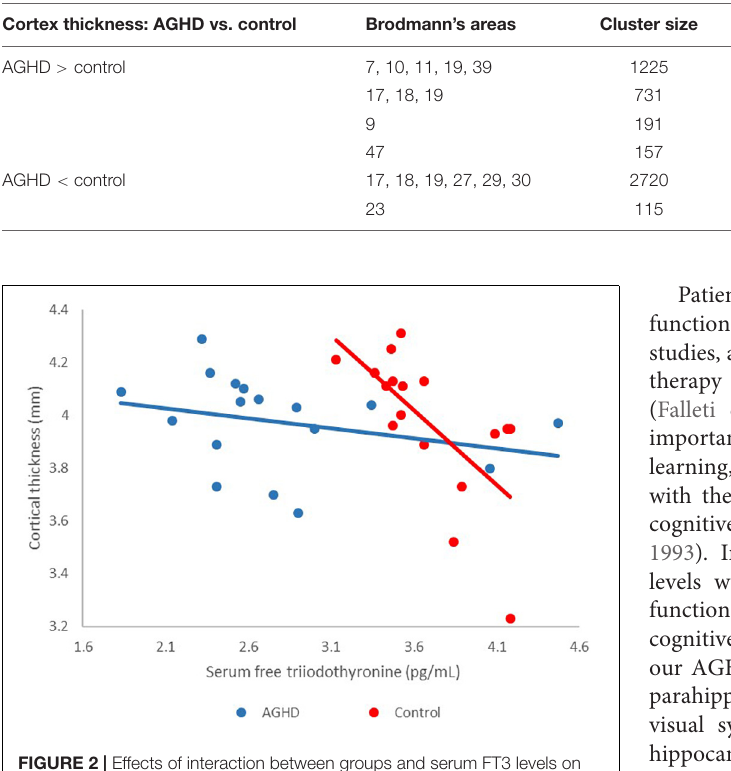
FIGURE 2 | Effects of interaction between groups and serum FT3 levels on cortical thickness. Red points, controls; blue points, AGHD